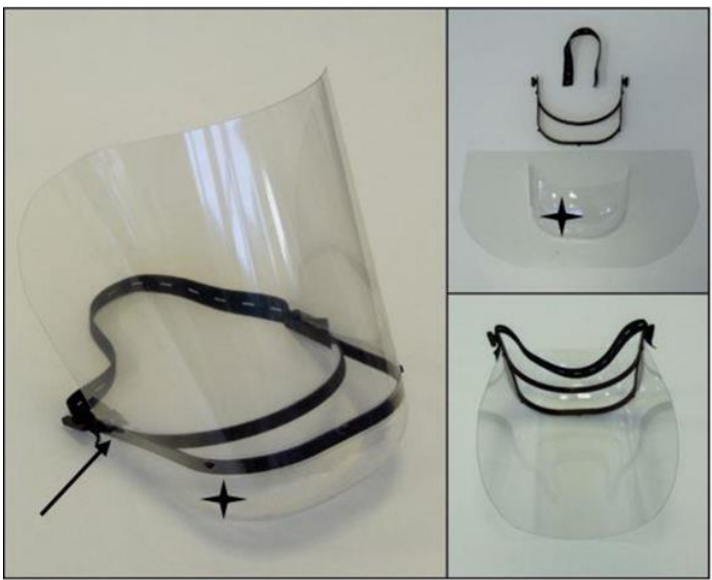
Figure 7. Shield V.2.0: The model improvements are marked as follows: Elongated head-mounted area to cover the face (black arrow) and adaptable cover for the top of the head (black star).